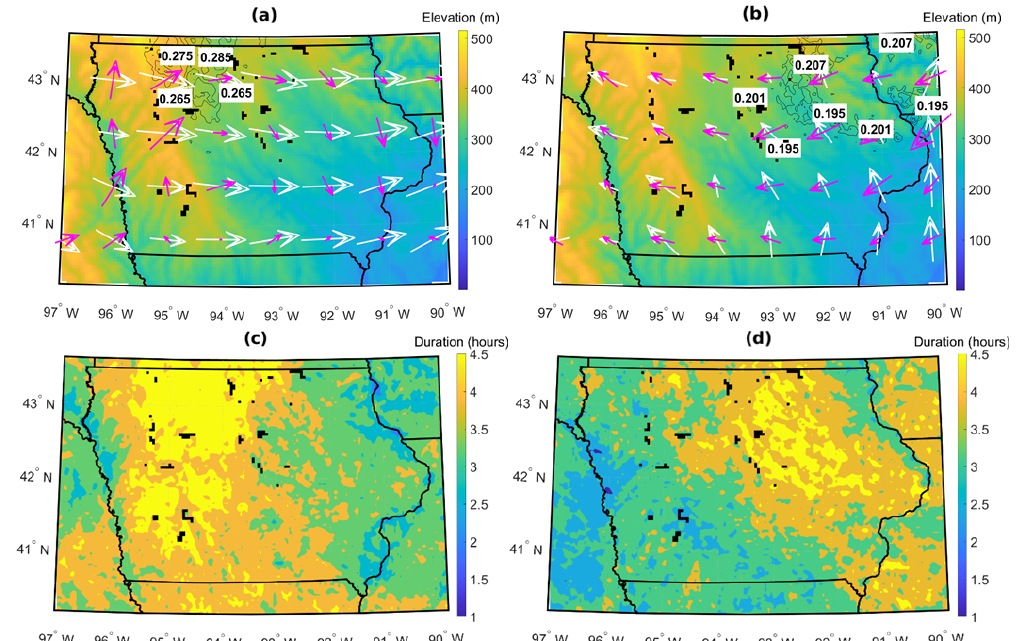
Figure 6. (a) December–February. Regional elevation (m) with contours of regions of highest 10% of LLJ frequency ( > 0 . 26). Average LLJ (pink) and non-LLJ (white) wind vectors at nominal turbine hub height of 100m. (b) March–May. Regional elevation (m) with contours (black; contour values given in white markers) of regions of highest 10% of LLJ frequency ( > 0 . 19). Average LLJ and non-LLJ wind vectors at nominal turbine hub height of 100m. (c) December–February. Regional mean LLJ duration. (d) March–May. Regional mean LLJ duration. Black markers indicate wind turbine